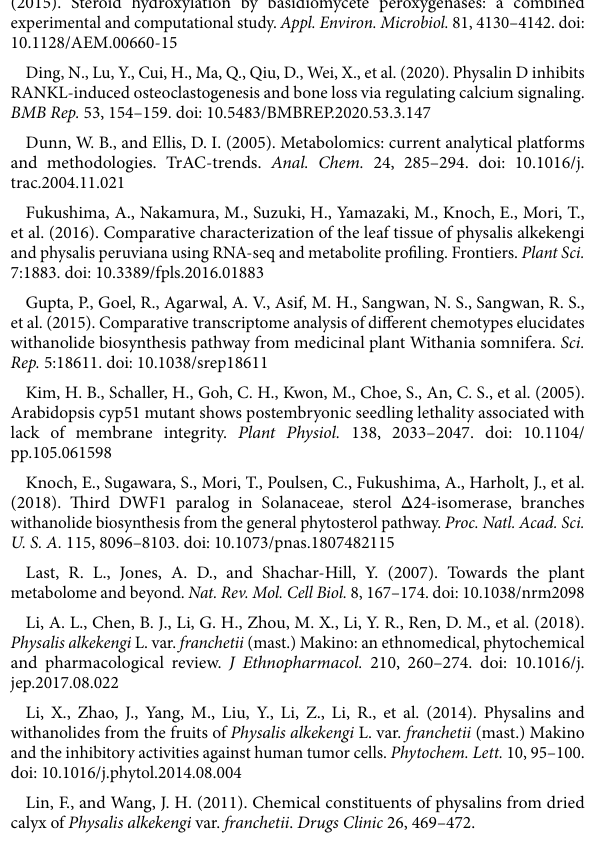
SUPPLEMENTARY FIGURE 5 MS spectra of physalin O and fragmentation pattern of the